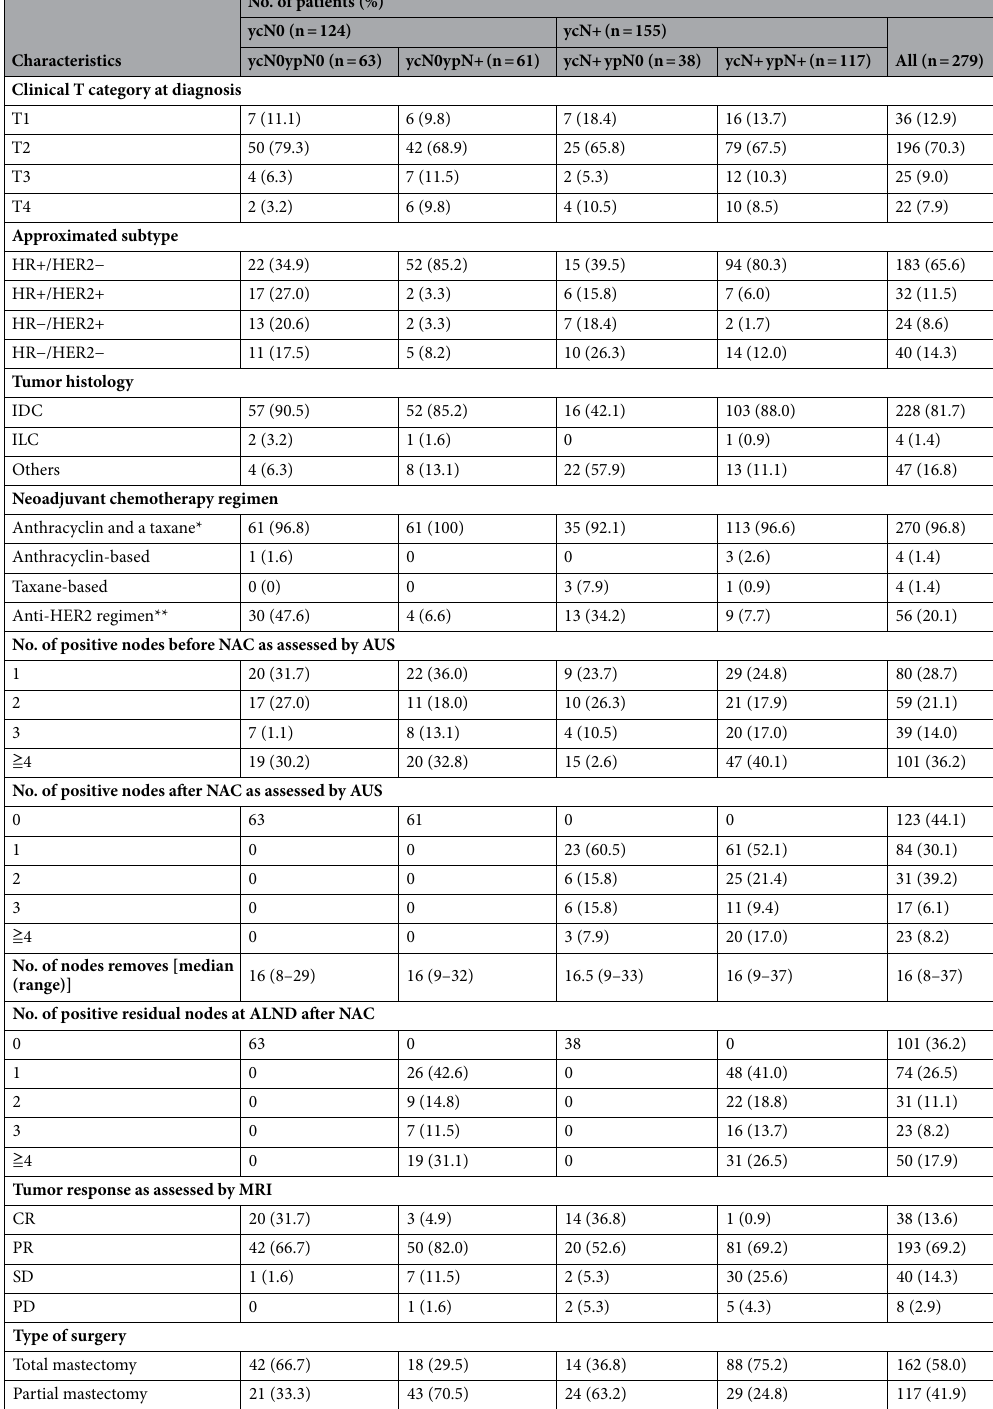
Table 1. Patient characteristics by pathological and clinical nodal status after NAC. ER estrogen receptor, HER2 human epidermal growth factor receptor 2, IDC invasive ductal carcinoma, ILC invasive lobular carcinoma, AUS axillary ultrasound, NAC neoadjuvant chemotherapy, ALND axillary lymph node dissection. * Two patients participated in clinical trial JBCRG17 and received an anthracycline- and taxane-based regimen plus eribulin. **Two patients participated in the NeoPeak clinical trial and received either pertuzumab and T-DM1 or pertuzumab, trastuzumab, docetaxel, and